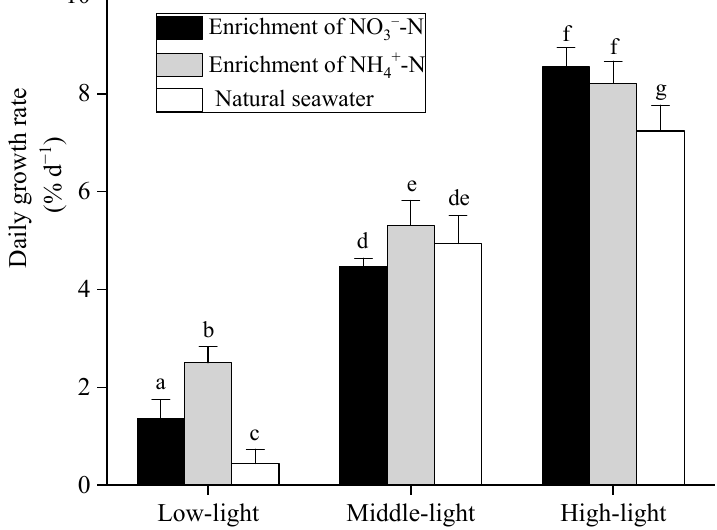
Figure 1. Daily growth rate (DGR) of Sargassum horneri grown at different light and N conditions for 10 days. Data are reported as means ± SD (n = 3). Different letters above the error bars indicate significant differences between treatments ( P < 0.05).